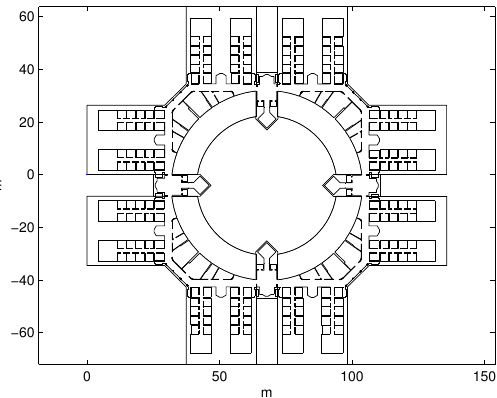
Figure 1. Plan in XML format of the third floor of the Engineering School, University of Alcalá (Spain).